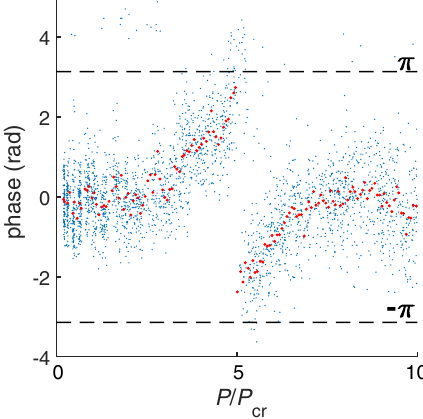
FIG. 4. Beam on-axis phase shift (with respect to flat-phase reference arm) as a function of pulse power at z phase jumps abruptly by ∼ 2 π at P=P signature of the transition from the precollapse to the postcollapse beam. The red points are averages over 2600 shots (blue points) in 150 energy